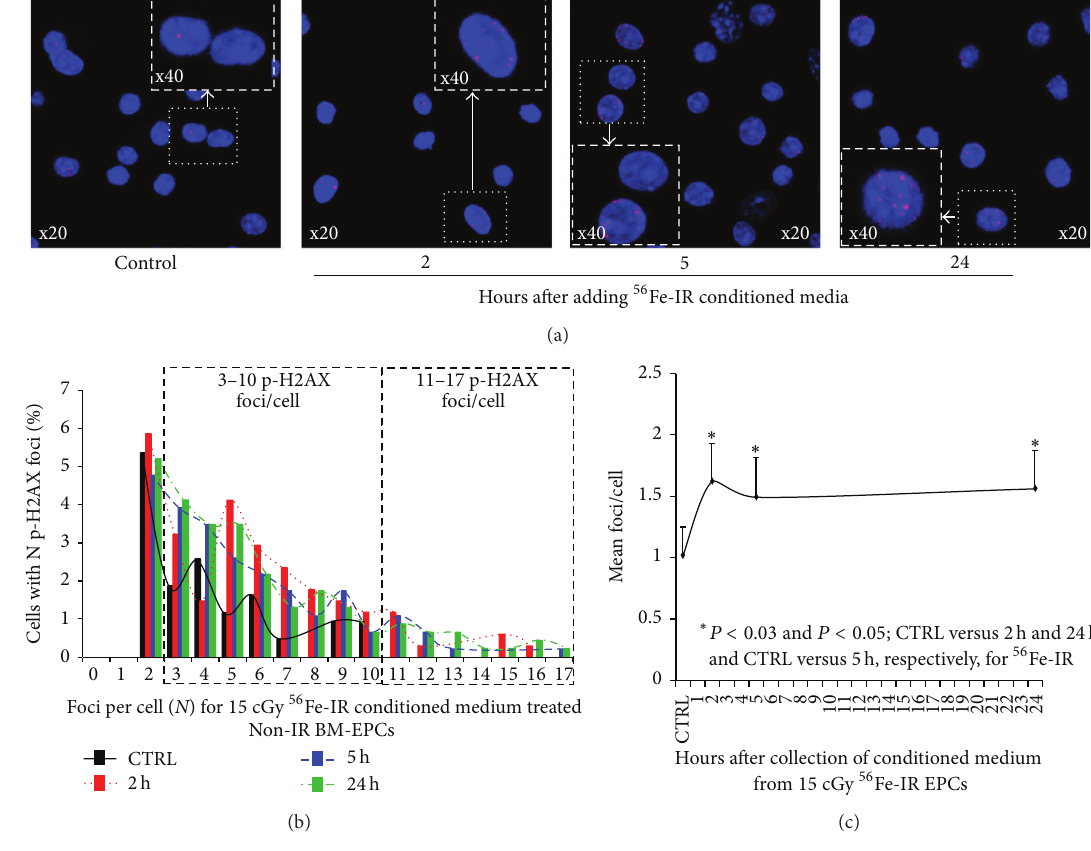
Figure 3: Nonirradiated BM-EPCs treated with 56 Fe-IR conditioned media exhibit increased number of p-H2AX foci/cell in vitro . (a) Representative confocal images of p-H2AX 24 h after treatment of Non-IR BM-EPCs with 56 Fe-IR-CM medium collected from duplicate set of respective EPCs 2, 5, and 24 h after 15 cGy 56 Fe-IR. (b) Mean p-H2AX foci distribution (with ≥ 2 p-H2AX foci/cell) in BM-EPCs treated with Non-IR- and 56 Fe-IR conditioned media (CM). Foci distribution plot for % of Non-IR BM-EPCs with a given number ( 𝑁 ) of foci after treatment for 24 h with CM from 15cGy 56 Fe-IR BM-EPCs at 2h (red bars and dotted lines), 5 h (blue bars and dashed lines), and 24 h (green bars and dashed/dotted lines) compared to Non-IR controls (black bars and solid lines). Due to no difference in the number of p-H2AX foci/cell between Non-IR and 56 Fe-IR treatment groups, graph represents distribution of p-H2AX foci/cell after excluding the cells with zero and 1 foci/cell. (c) Mean p-H2AX foci/cell plotted for control, 2 h, 5 h, and 24 h treatment time point after treatment of BM-EPCs with 56 Fe-IR CM. Graphs represent mean ± SEM of the pooled data from 5 to 6 independent biological samples/experiments. Statistical significance was assigned when 𝑃 < 0.05